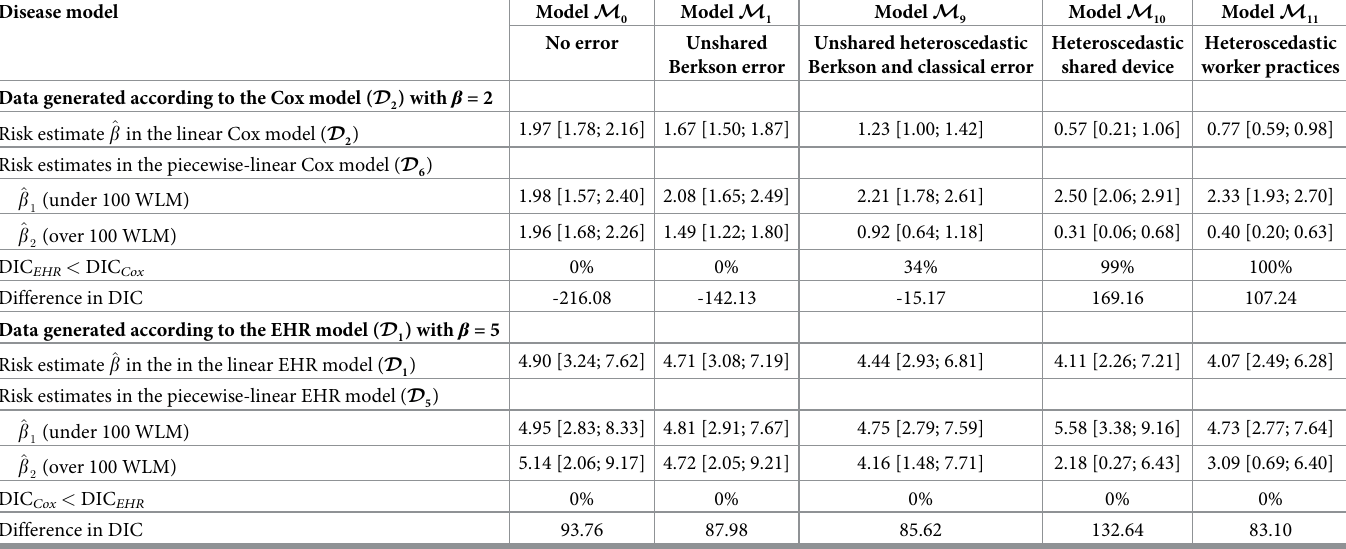
Table 3. Comparison of risk estimates when data are generated according to different disease and measurement models. DIC realisations for which the Deviance Information Criterion (DIC) was smaller for the Excess Hazard Ratio (EHR) model when the true model was the Cox model and vice versa for DIC < DIC . The difference in DIC is calculated as difference between the EHR model and the Cox model. Cox EHR